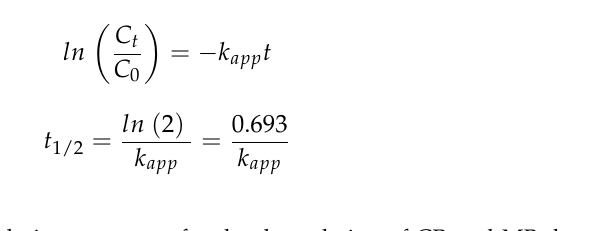
Table 2. Summary of photocatalytic parameters for the degradation of CR and MB dyes using rGO/CuO